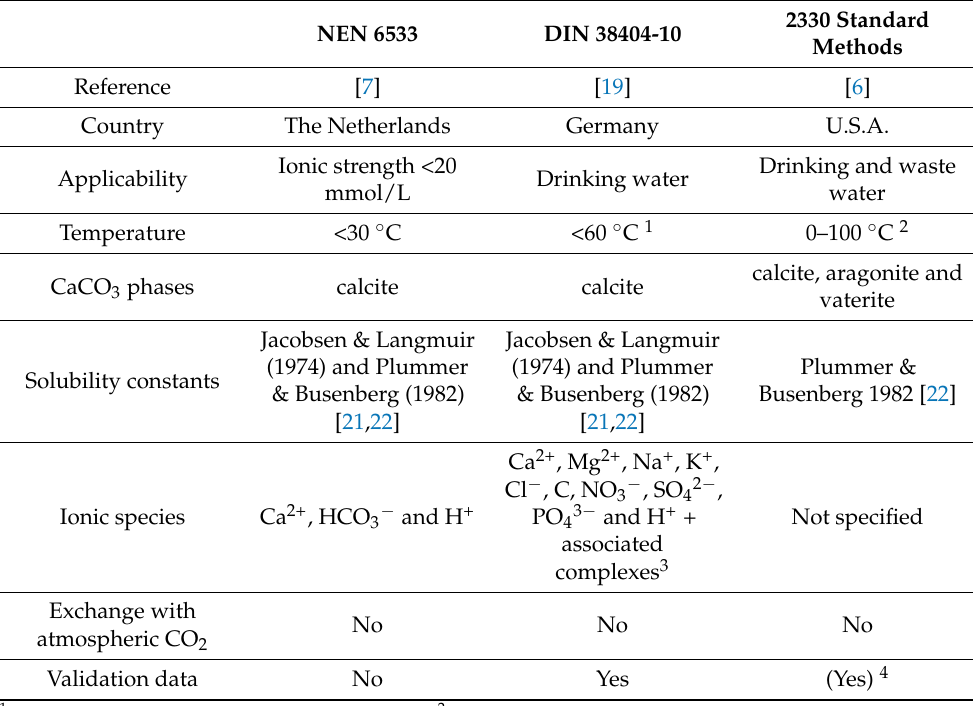
Table 1. Comparison of existing standards for calculating the calcium carbonate precipitation potential (CCPP). NEN